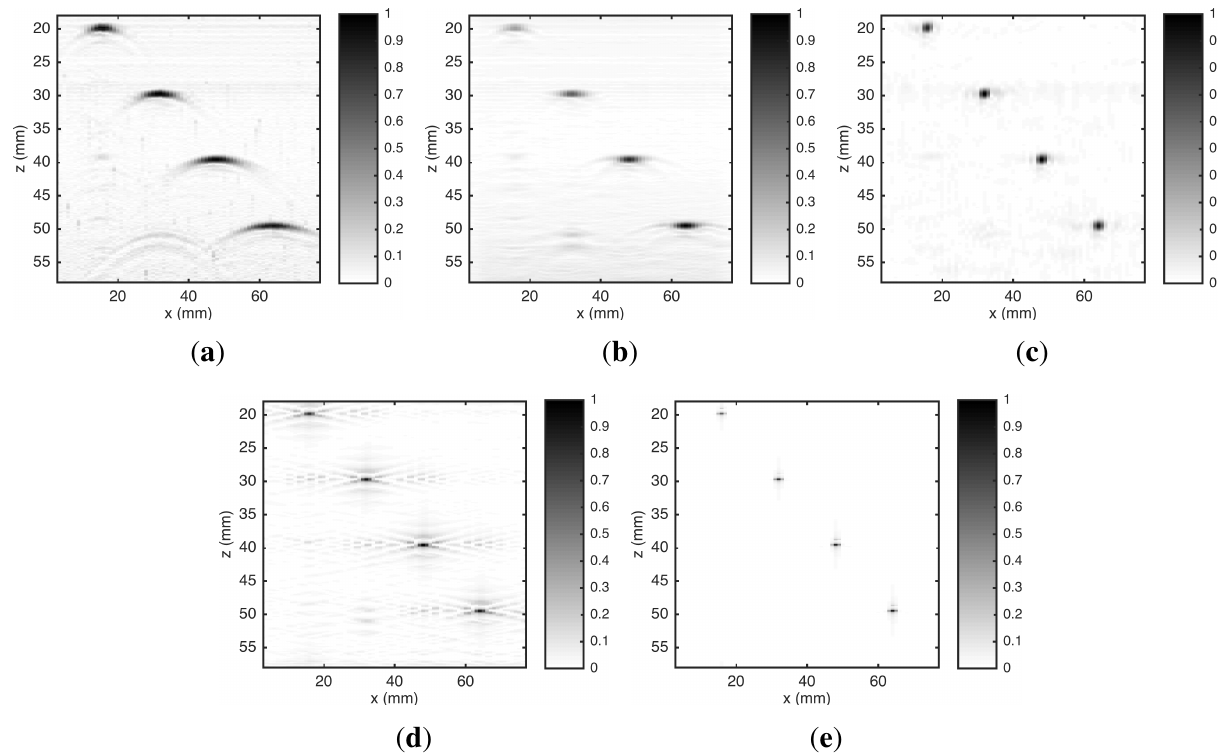
Figure 8. Reconstructed images of a steel block with four SDHs with 1 mm of diameter from real data acquired by the UIS. The algorithms used in the reconstruction are: ( a ) B-scan ; ( b ) SAFT; ( c ) ω - k SAFT; ( d ) RLS and ( e ) UTSR. Amplitude scale was normalized to maximum absolute